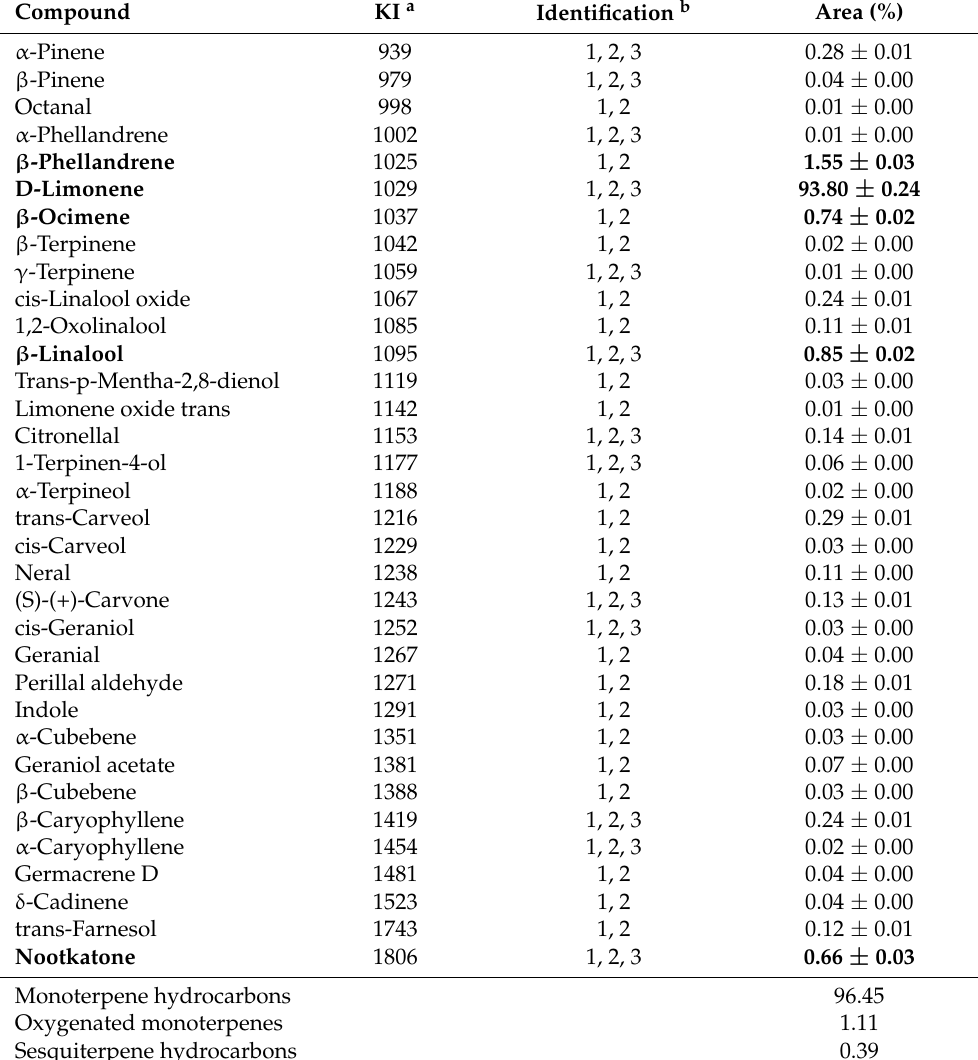
Table 2. Chemical composition of the C. lumia ‘Pyriformis’ EO. Results are expressed as the mean area percentage (%) ± the standard deviation (SD) of three independent determinations in triplicate ( n =